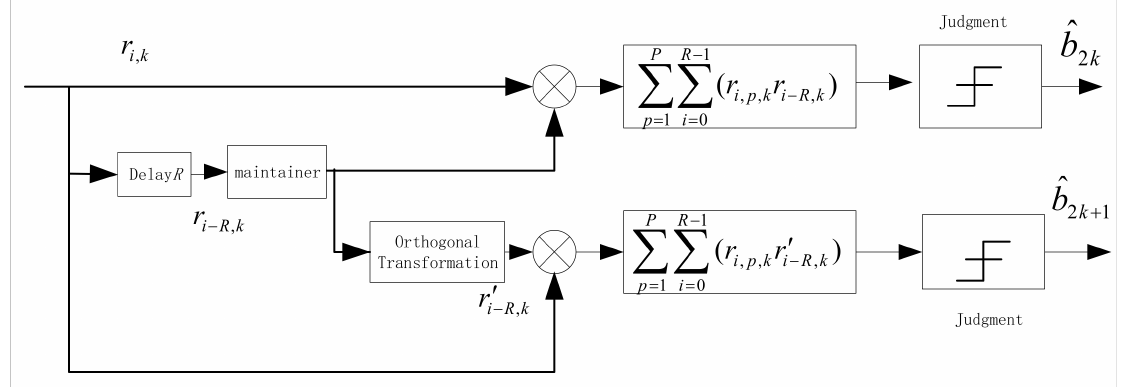
Figure 5. Receiver structure of the